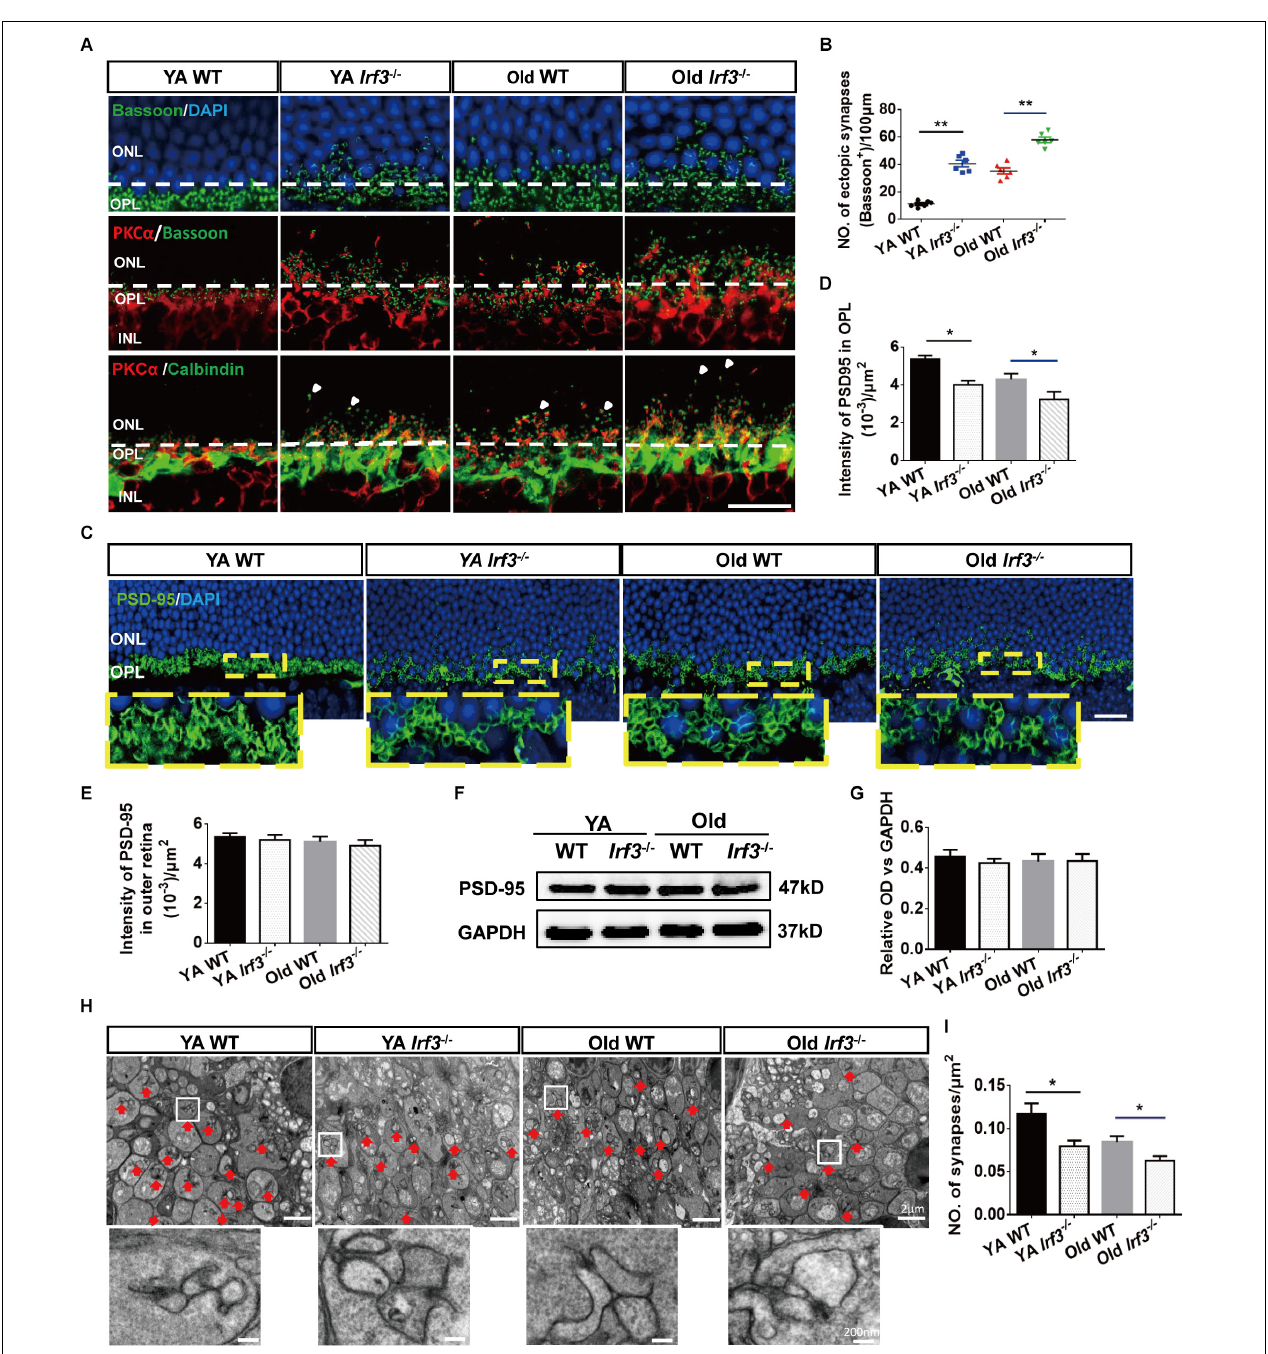
FIGURE 4 | IRF3 deficiency induces age-related synaptic changes in the retina. (A) Immunostaining for synaptic ribbon (bassoon, green), cell nuclear (DAPI, blue), rod bipolar cells (PKC α , red) and horizontal cells (calbindin, green). Ectopic pre-synapse (Bassoon) entered the ONL layer in YA and Old Irf3 − / − mice and old WT. Synaptic contacts between rod photoreceptors (Bassoon) and rod bipolar cell dendrites (PKC α , red) had the same changes in YA and Old Irf3 − / − mice and Old WT mice. Mislocation processes of rod bipolar and horizontal cells (arrows) were synchronously observed in YA and Old Irf3 − / − mice and Old WT mice. The white dotted line indicates the border of OPL/ONL. Scale bar = 20 µ m. (B) The sprout synapses beyond the border (white dotted line) were quantified. Data are presented as mean ± SEM ( ∗∗ P < 0.01, n = 6 per group). (C) Expression and localization of PSD-95 (photoreceptor synapse, green) in each group. Scale bars = 20 µ m. (D) The quantification of average fluorescence intensity of PSD-95 in the OPL. Data are presented as mean ± SEM ( ∗ P < 0.05, n = 4 per group). (E) The quantification of average fluorescence intensity of total PSD-95 in outer retina. Data are presented as mean ± SEM from 4 animals per group. (F,G) The levels of PSD-95 were not significantly altered in YA or Old Irf3 − / − mice or Old WT. Protein levels were assayed by immunoblot analysis (F) , quantified in (G) . Data are presented as mean ± SEM from 4 animals per group. (H) Representative electron microscope images show rod spherule synapses in the OPL of YA WT, Old WT, YA and Old Irf3 − / − mice (red arrow). Scale bar = 2 µ m. White boxes are high magnifications of synaptic structures (Scale bar = 200 nm). (I) The quantification of the synapses density within the OPL of the retinas. Data are presented as mean ± SEM of 64 fields from 4 animals in each group ( ∗ P < 0.05, ∗∗ P < 0.01, n = 4 per group).